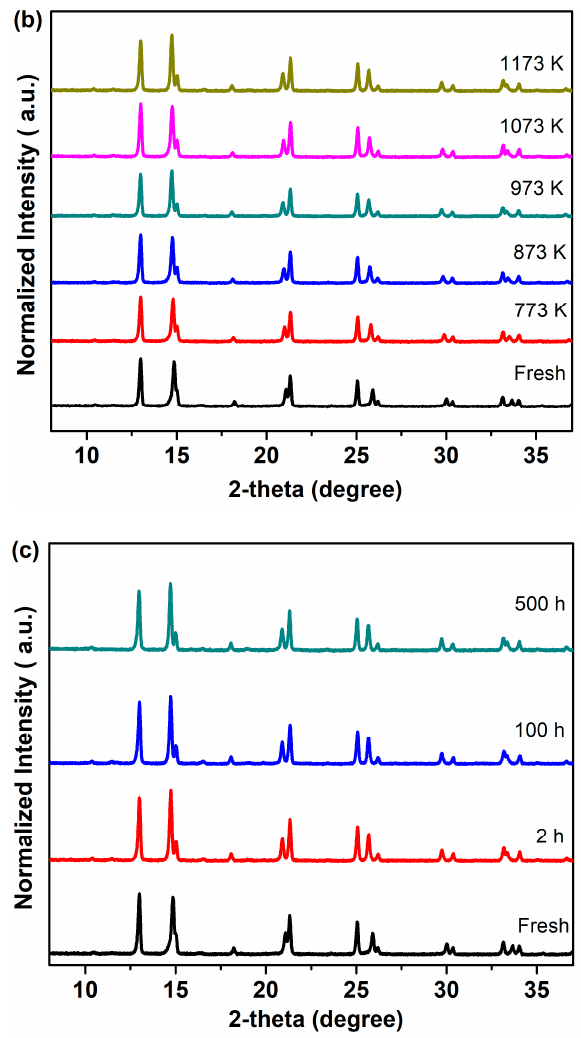
Figure 7. XRD patterns of the Ce 0.9 Pr 0.1 O 2 − δ –Nd x Sr 1 − x Fe 0.9 Cu 0.1 O 3 − δ ( x = 0.2, 0.5, 0.8) powder samples after exposure to the CO 2 atmosphere: ( a ) at 1173 K for 100 h; ( b ) Ce 0.9 Pr 0.1 O 2 − δ –Nd 0.5 Sr 0.5 Fe 0.9 Cu 0.1 O 3 − δ sample at different temperatures for 2 h; ( c ) Ce 0.9 Pr 0.1 O 2 − δ –Nd 0.5 Sr 0.5 Fe 0.9 Cu 0.1 O 3 − δ sample for different times at 1173 K.